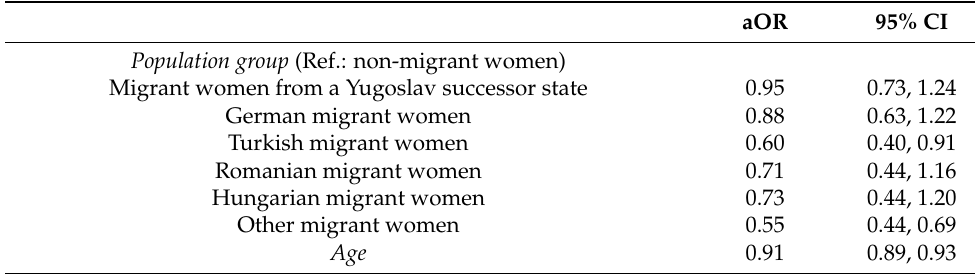
Table 2. Results of the multivariable logistic regression model with the utilization of cervical cancer screening in the last 3 years as the dependent variable: adjusted odds ratios (aOR) and 95% confidence intervals (95% CI) (Austrian Health Interview Survey 2019, women aged 20–69 years, n = 6228; main effects model. No interaction effects